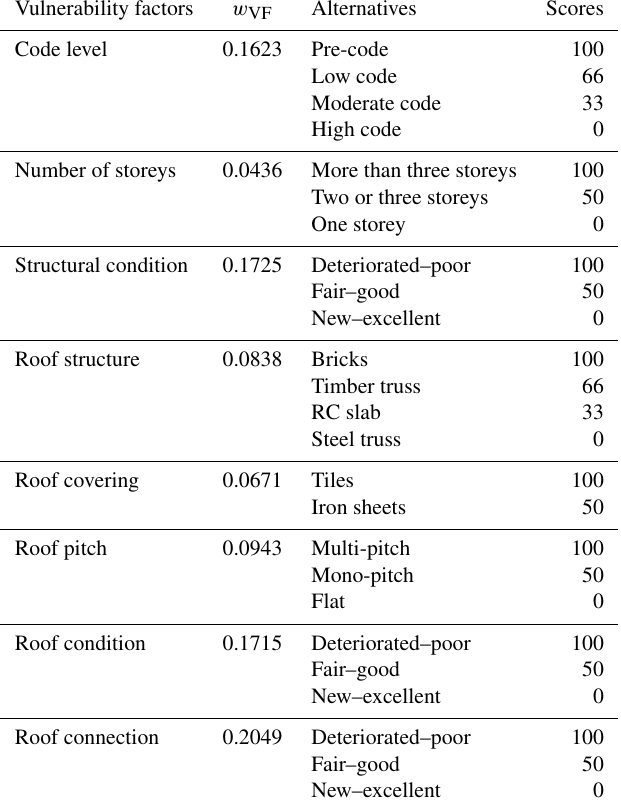
Table 5. Wind vulnerability factors: definition, alternatives, scores and